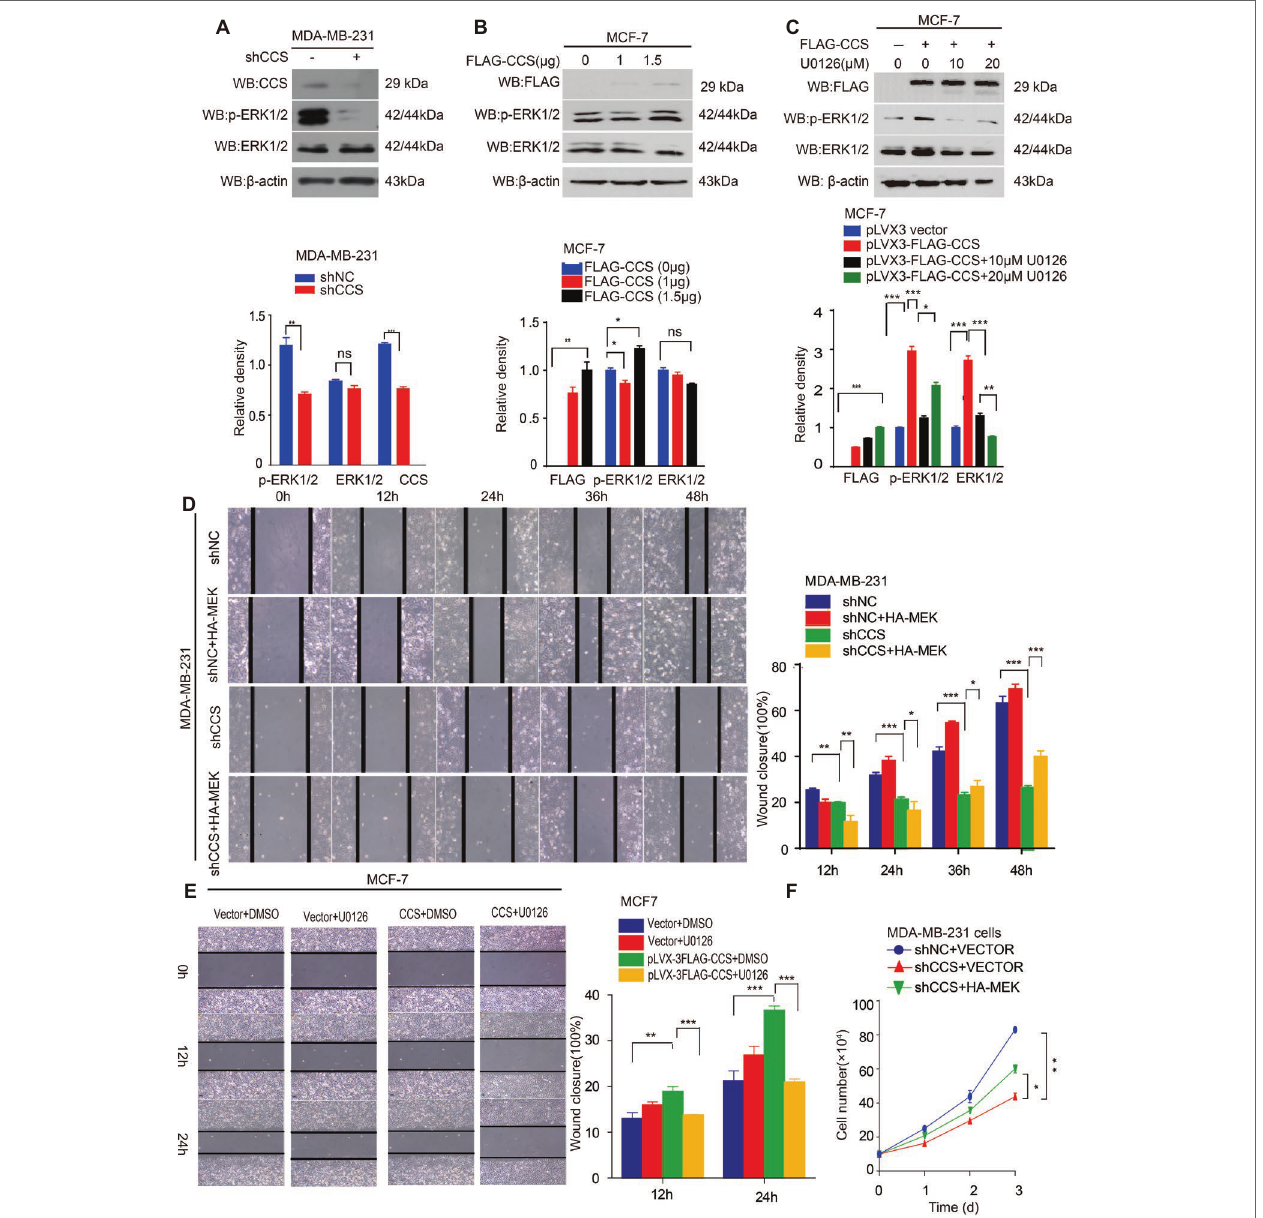
FIGURE 4 | CCS promotes breast cancer cell migration and cell proliferation via ERK1/2 activity. (A) Phosphorylated ERK1/2 and total ERK1/2 levels were determined in CCS knockdown MDA-MB-231 cells by western blotting. (B) Phosphorylated ERK1/2 and total ERK1/2 levels were determined in CCS overexpressing MCF-7 cells by western blotting. (C) Phosphorylated ERK1/2 and total ERK1/2 levels were determined in CCS overexpressing MCF-7 cells treated with increasing concentrations of U0126 for 12 h by western blotting. (D) Cell migration in CCS knockdown and control MDA-MB-231 cells as determined by wound healing assay when overexpressing exogenous HA-tagged MEK. (E) Cell migration in CCS overexpressing and control MCF-7 cells treated with U0126 was determined by wound healing assay. The modified migration assay was evaluated by calculating the ratio of the cell numbers through the chamber or wound closure after the wound healing assay. (F) Cell proliferation was determined by cell number counting assays in CCS stable knockdown MDA-MB-231 cells with overexpression of exogenous HA-tagged MEK. All results performed above are presented as mean ± SD from three independent experiments. * p < 0.05; ** p < 0.01; *** p < 0.001, ns not